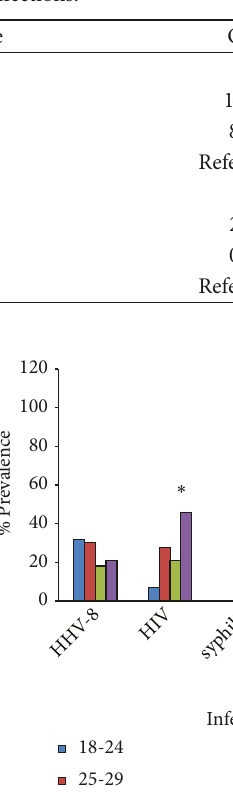
Figure 2: The prevalence of HHV-8, HIV, and syphilis mono- and coinfections across different age groups among female sex workers in Malindi, Kenya, in 2015-2016. Asterisks ( ∗ ) show infections that recorded significant association with